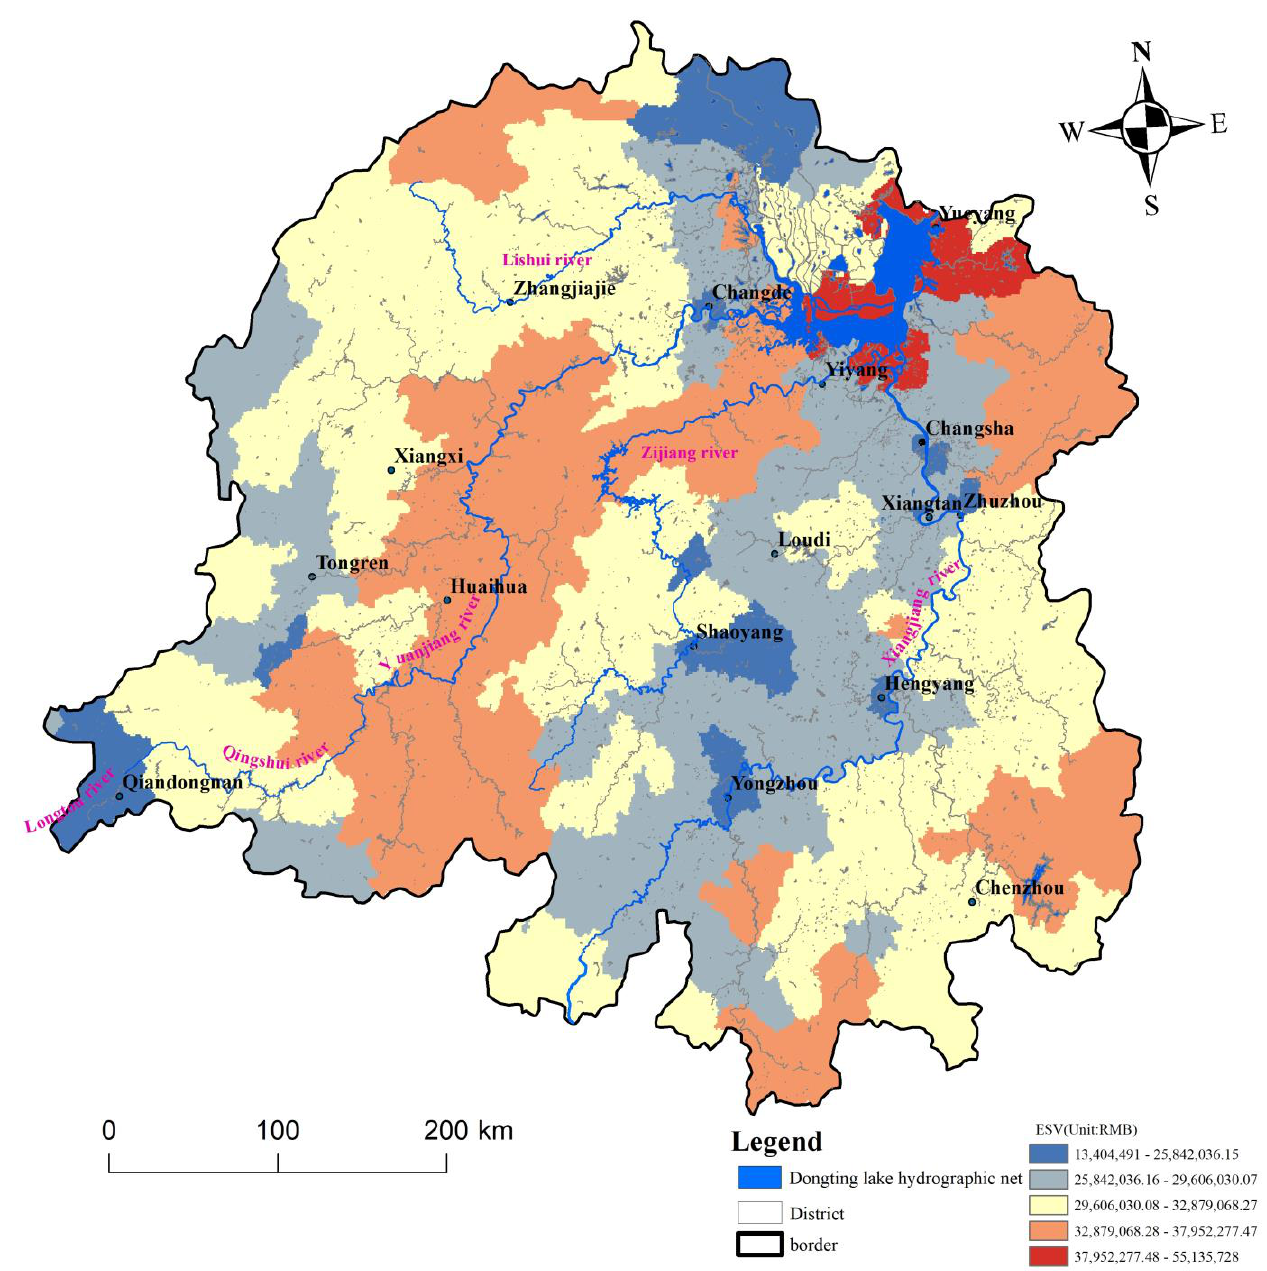
Figure 6. ESVs of each county.